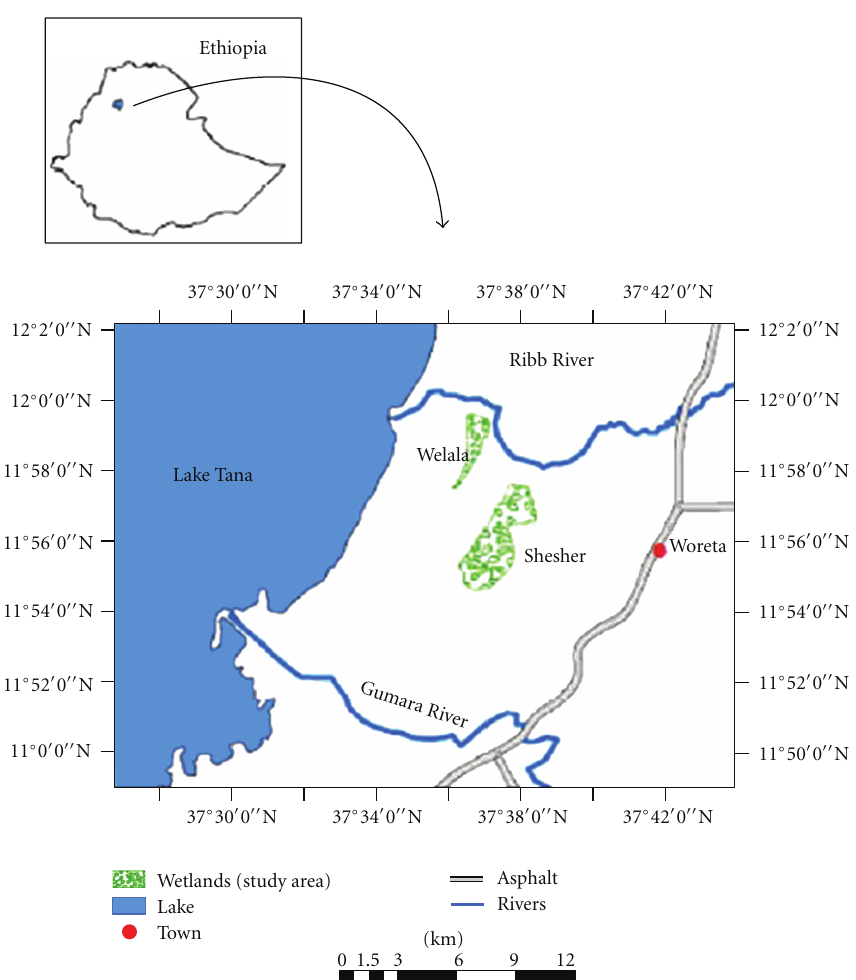
Figure 1: Map of Lake Tana and Ribb River and associated Shesher and Welala floodplain wetlands (after Atnafu et al. [18]).